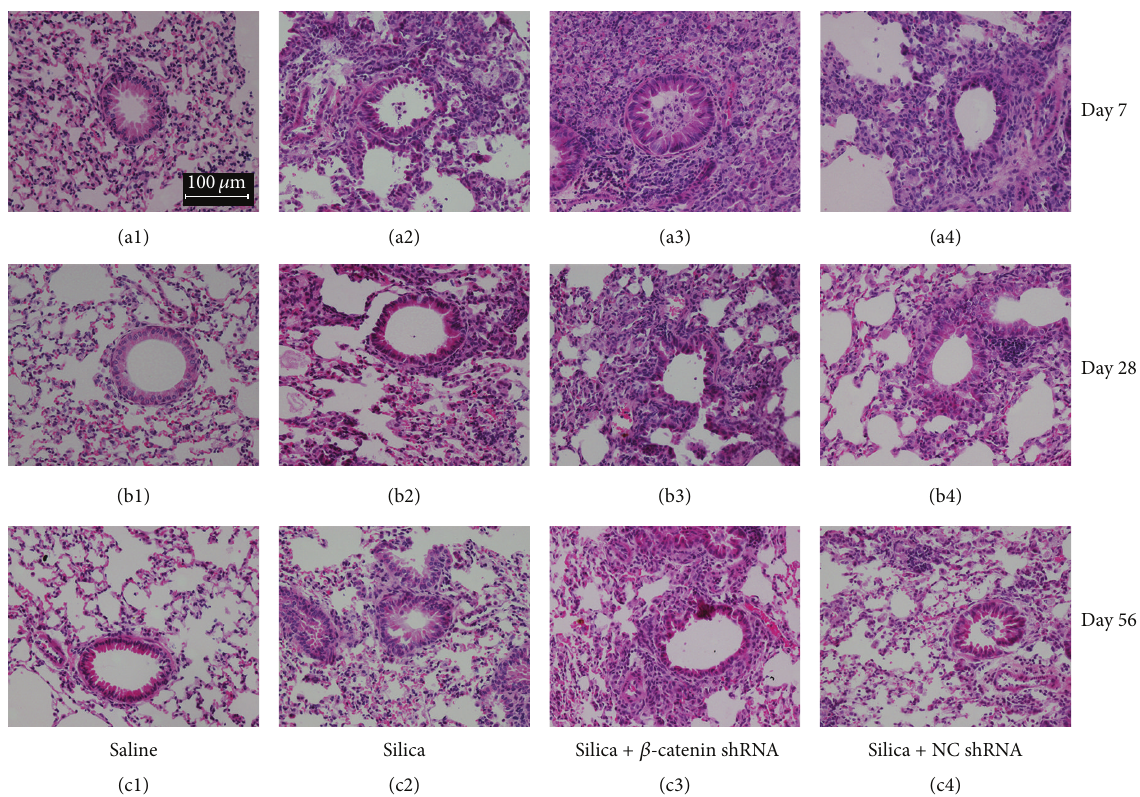
Figure 1: Blockade of Wnt/ 𝛽 -catenin pathway aggravated the silica-induced lung inflammation. Lung sections from C57BL/6 were stained with H&E and observed under the light microscope (magnifications × 200). Histopathological changes were assessed in saline group (a1–c1), silica group (a2–c2), silica + 𝛽 -catenin group (a3–c3), and silica + NC shRNA group (a4–c4) at days 7 (a1–a4), 28 (b1–b4), and 56